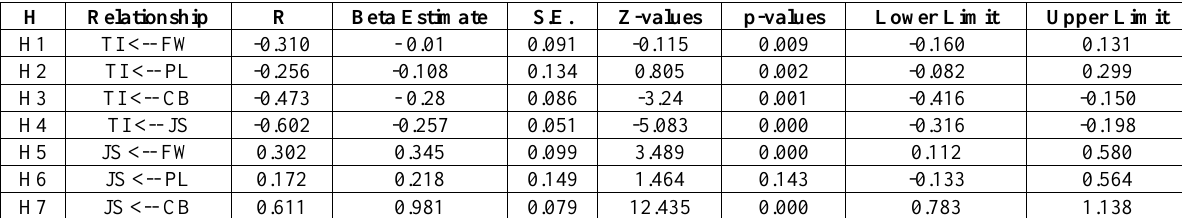
Table 4. Hypothesis Testing for Direct Effect